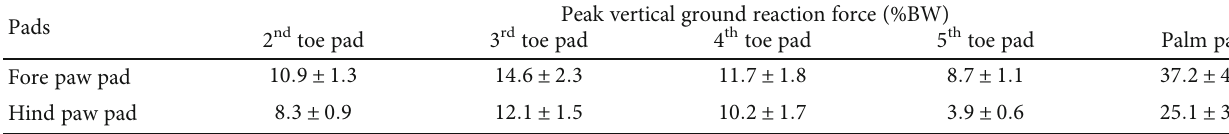
Table 1: Peak vertical ground reaction force in each area of the fore and hind paw pads of cats.